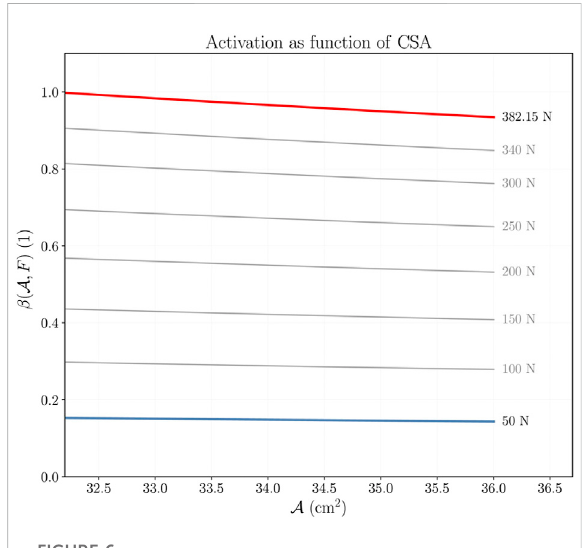
FIGURE 6 Activationlevel β asafunctionoftheCSA A fordifferentforce levels. The activation required to produce a fi xed force decreases as the CSA of the structure increases. Each curve results by fi xing the value of F and calculating β according to Supplementary Equations S24, S25.